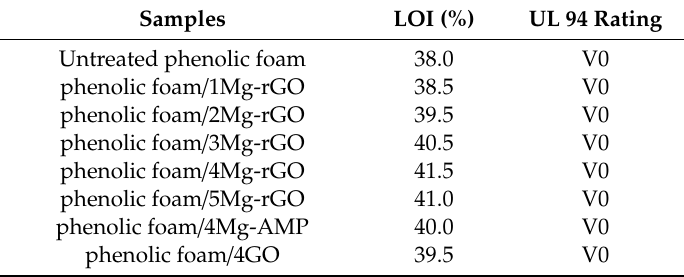
Table 4. Limiting oxygen index (LOI) and UL 94 rating of untreated and toughened phenolic foam, reproduced from [130] with permission, copyright Elsevier,